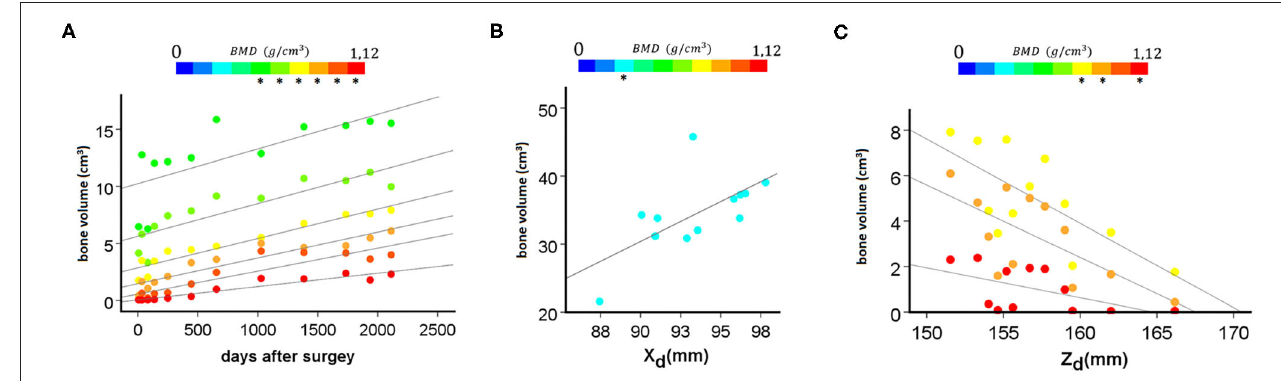
FIGURE 10 | Association between BMD categories’ volumetric change and the days after surgery and the distance of the mobile (L2 right pedicle screw tip) point from the fixed point (left, caudal trans iliac screw tip) in the anatomical planes. (A) Significant positive, very strong correlation ( ρ > 0.800, p < 0.050) was found between the highest 6 BMD categories (marked with “*”) and the days after surgery. (B) Significant positive, strong correlation was found between the X d (frontal plane) and the third BMD category ( ρ = 0.678, p = 0.015). (C) Significant negative, strong correlation ( ρ > 0.600, p < 0.050) was found between 3 high value BMD categories (marked with “*”) and the Z d (sagittal plane)